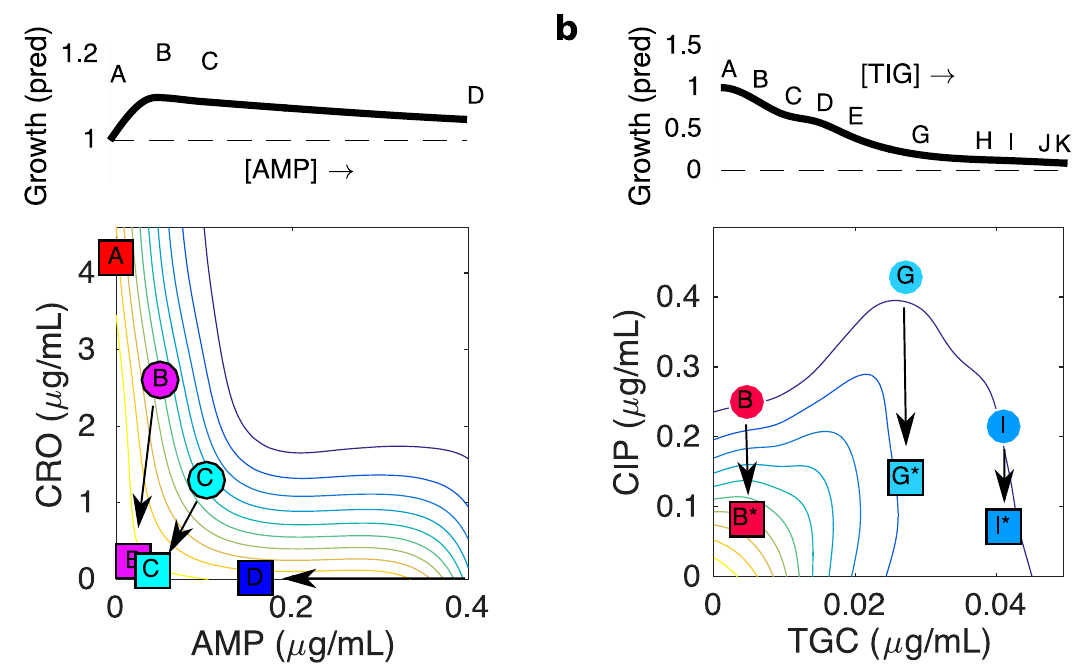
Fig 5. Geometric rescaling of growth surface in ancestral strain explains growth differences between different conditions even when resistance profiles are identical. Main panels: contour plots show growth in ancestral (WT) strain as function of drug concentrations for AMP-CRO (a, left) and TGC-CIP (b, right). Circles indicate selecting conditions (note that for visualization purposes, several selecting conditions are outside of the axis limits). Squares indicate effective concentrations achieved by rescaling true concentrations by the observed (mean) fold change in IC 50 for each drug. All arrows in a single panel correspond to the same rescaling: AMP ! AMP/2.5, CRO ! CRO/ 11.6 (panel a) and CIP ! CIP/3.0, TGC ! TCG (panel b). The rescaling factors correspond to cross resistance to AMP and CRO, with CRO resistance larger than AMP resistance (panel a) and to CIP resistance with no change in TGC resistance (panel b), which correspond to the mean values observed experimentally over all populations in AMP-CRO (see Fig 1) and the CIP-resistant populations in TGC-CIP (see Fig 4). Upper panels: predicted change in growth (relative to condition A) as one moves along the original contour, starting at condition A (one drug only). Predicted growth rate is calculated using 2d interpolation to estimate the growth along the rescaled contour on the ancestral growth